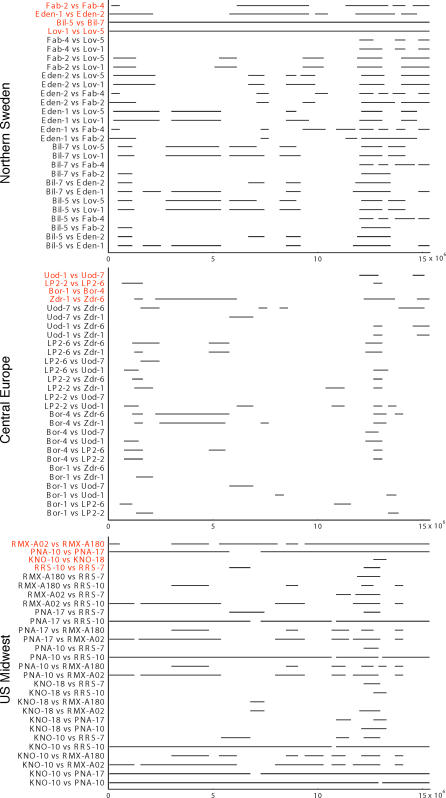
Haplotype Sharing on Chromosome 4 among Pairs of Individuals in the Population Samples from Northern Sweden, Central Europe, and the USThe lines indicate regions where the particular pair of accessions share at least five identical adjacent fragments. Within-population comparisons are highlighted in red. The patterns in southern Sweden and in the UK are similar to that in central Europe.